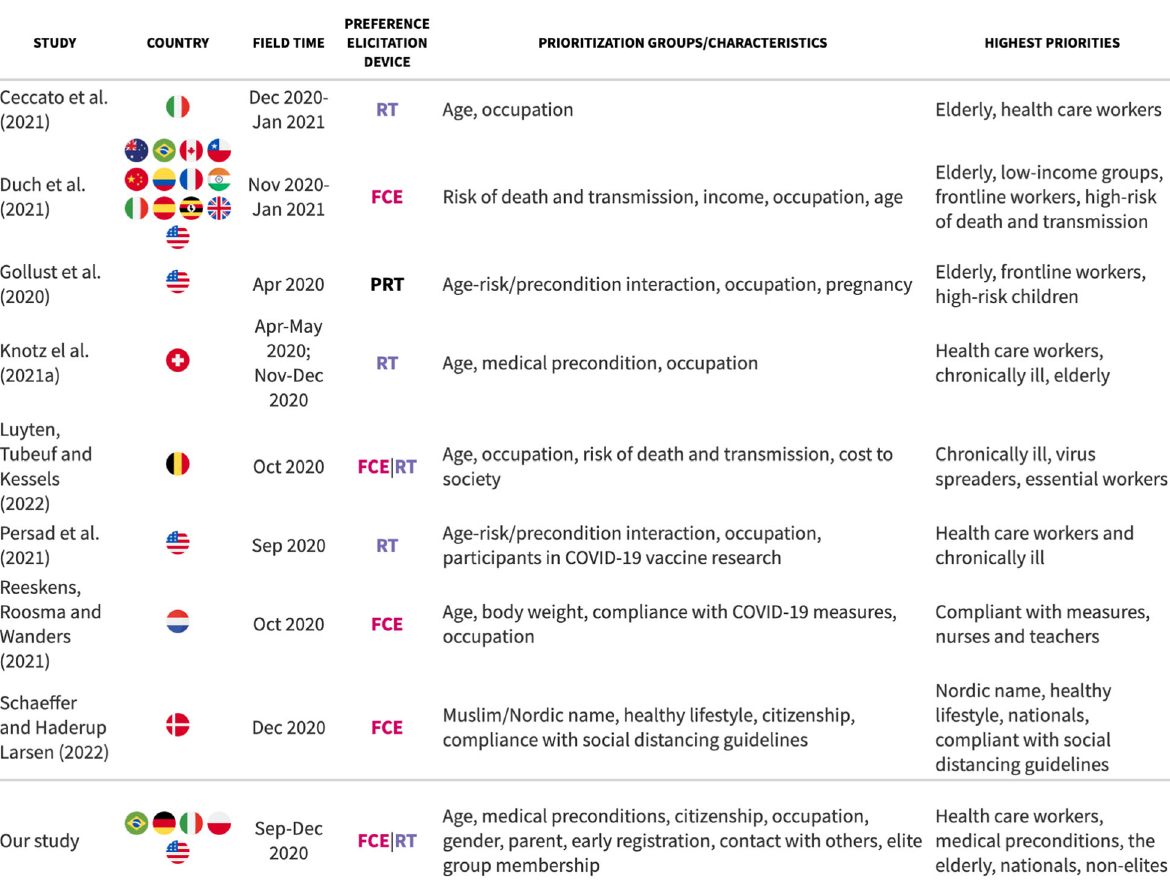
FCE forced-choice experiment, RT ranking task, PRT priority rating